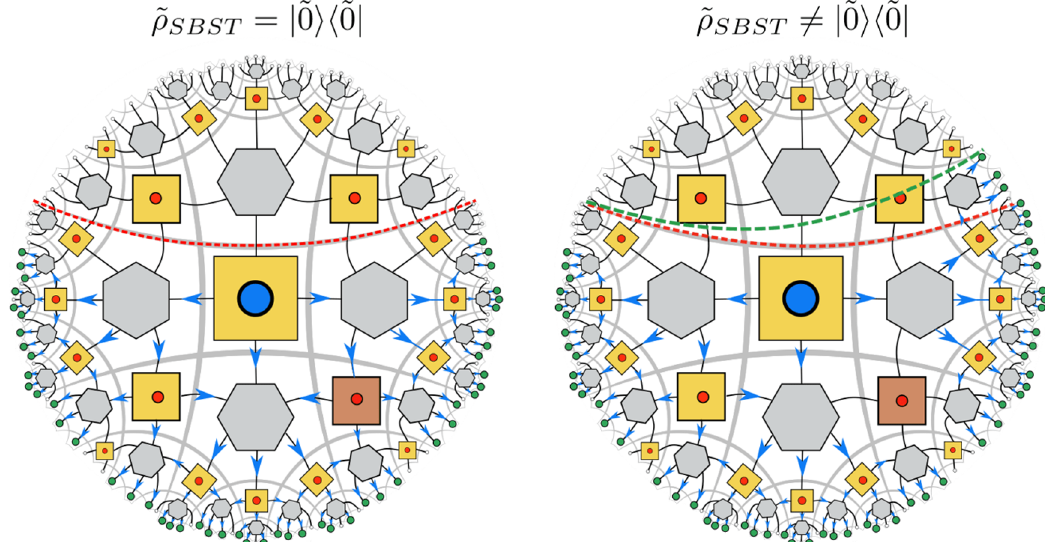
Figure 35. The darkened tensor correspond to the insertion of SBST. Operator pushing rules are different depending on the state. The central qubit can be fully accessed in the subregion below the red curve when the marked tile is in the 0 state. However, a larger subregion bounded by the green curve is needed, if the marked tile is in an another